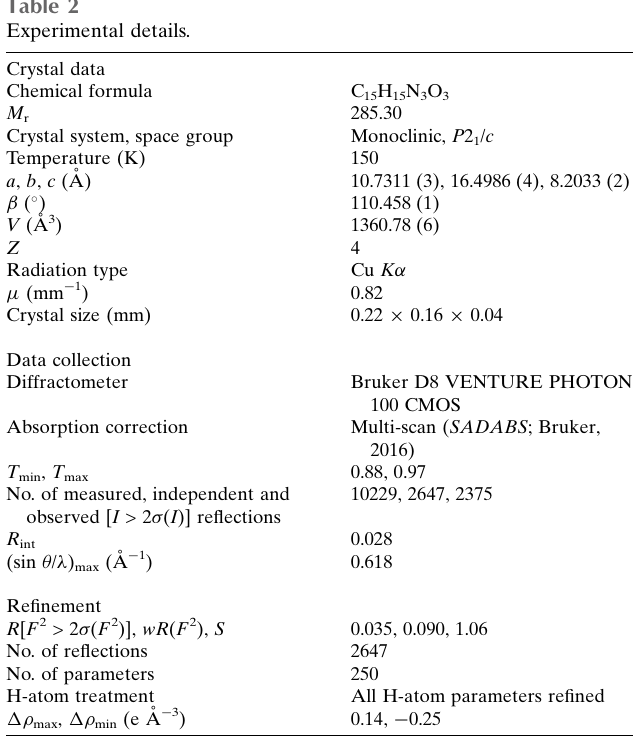
Table 2 Experimental details.